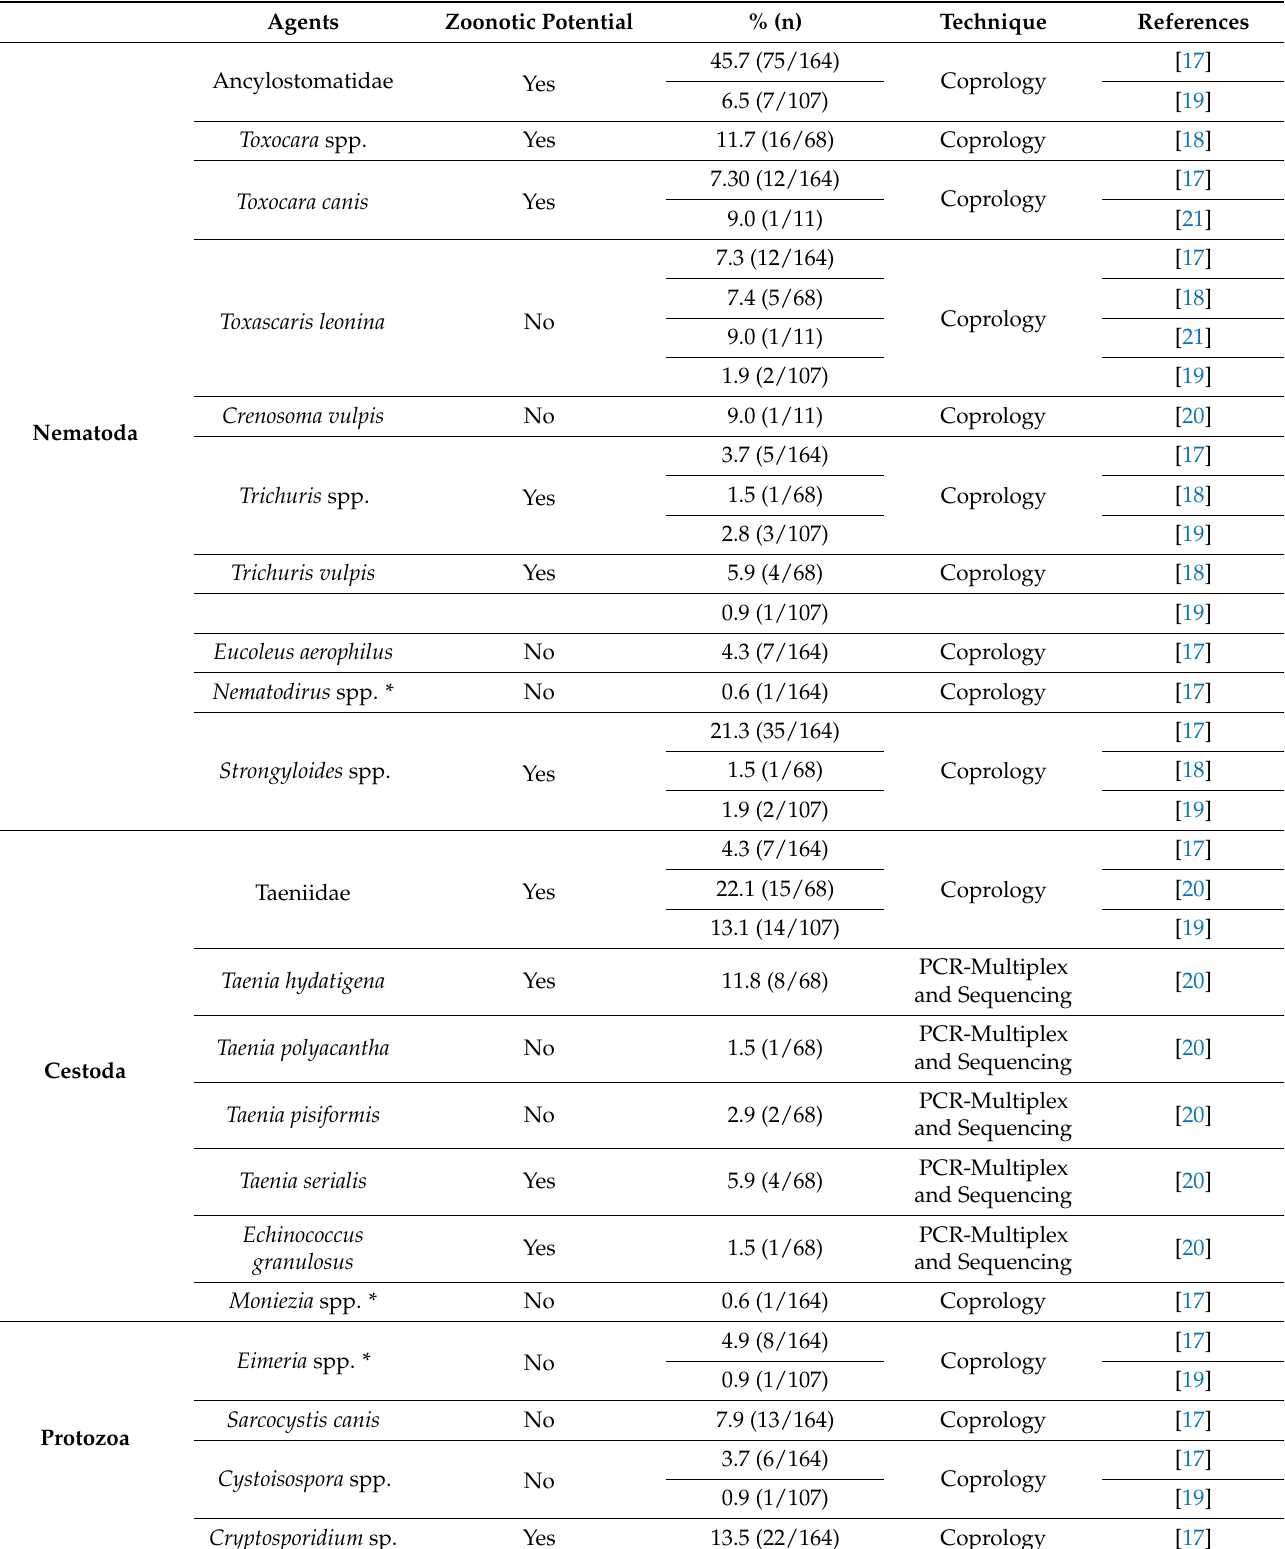
Table 2. Prevalence (%) of parasitic agents reported in wolves in Portugal